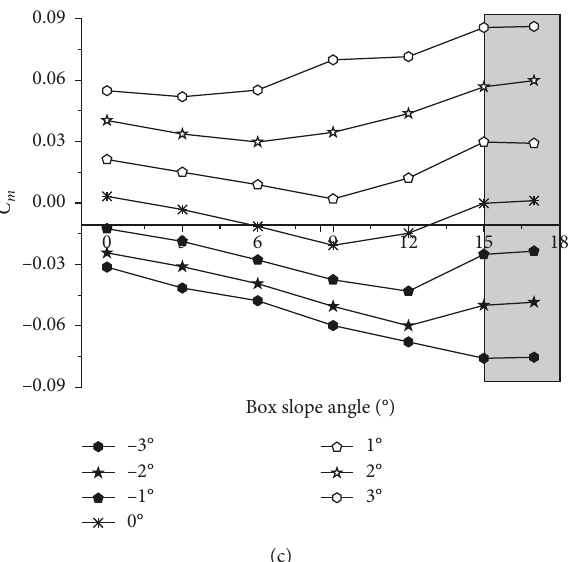
Figure 19: Variation of aerodynamic static coefficients with the box slope angle for AOA from − 3 ° to 3 ° : (a) C